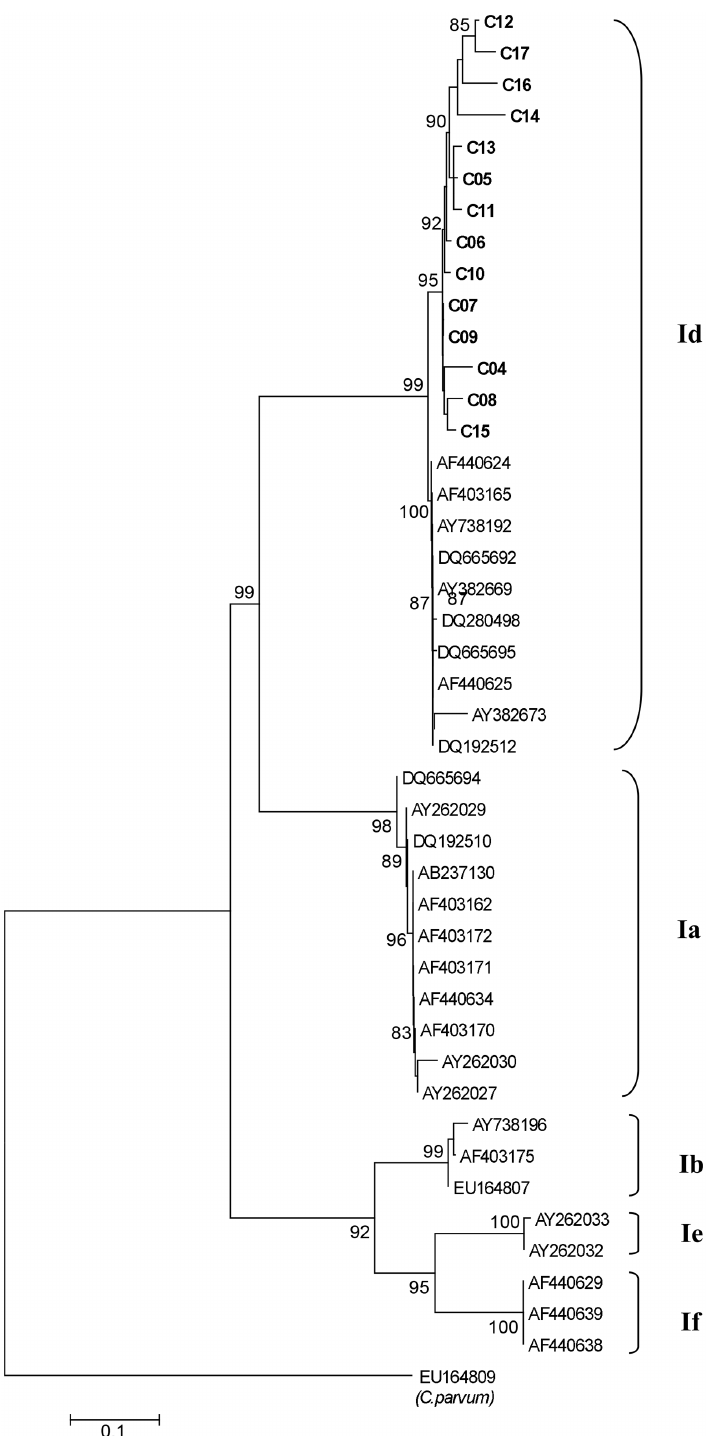
Fig 3. Phylogenetic analysis of Cryptosporidium hominis gp60 sequence data using neighbour- joining analysis. Sequences from the present study (C04, C05, C06, C07, C08, C09, C10, C11, C12, C13, C14, C15, C16 and C17) as well as reference sequences representing C . hominis sub-genotypes (acquired from GenBank) are indicated. The evolutionary distances were computed using the Kimura 2-Parameter method, with C. parvum (EU164809) as an outgroup. Bootstrap values greater than 80% from 1,000 replicates are